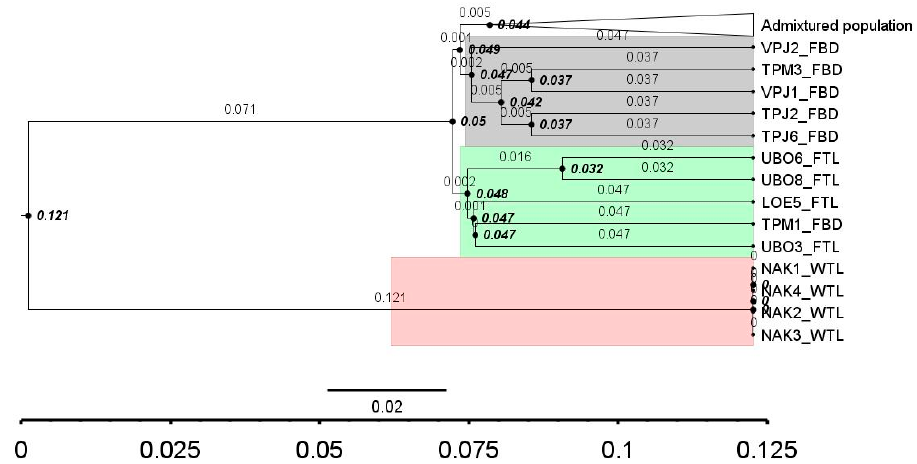
Figure 5. Time divergence between lineages. Number in bold is node relative time, normal number is branch times. Admixture population included all samples from Cambodia and Vietnam, 3 samples from Bangladesh (4%). Stock acronyms are given in Table 1.